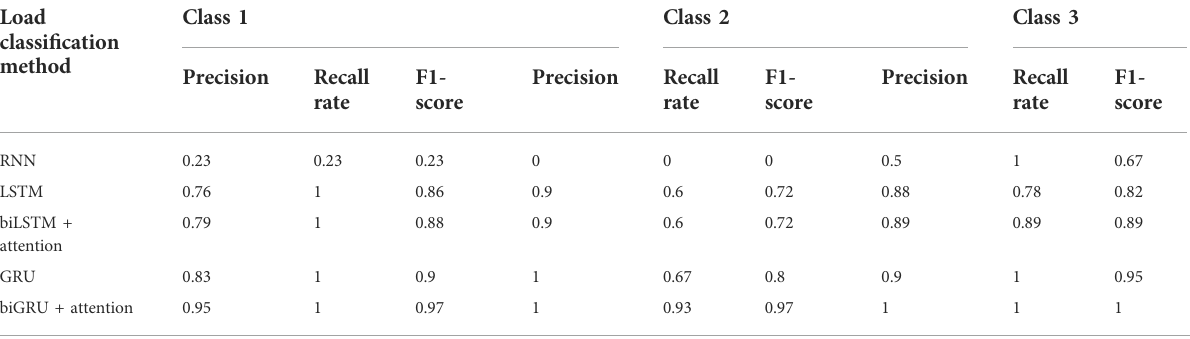
TABLE 12 Comparison of precision of load classi fi cation methods with different classes using the Wine